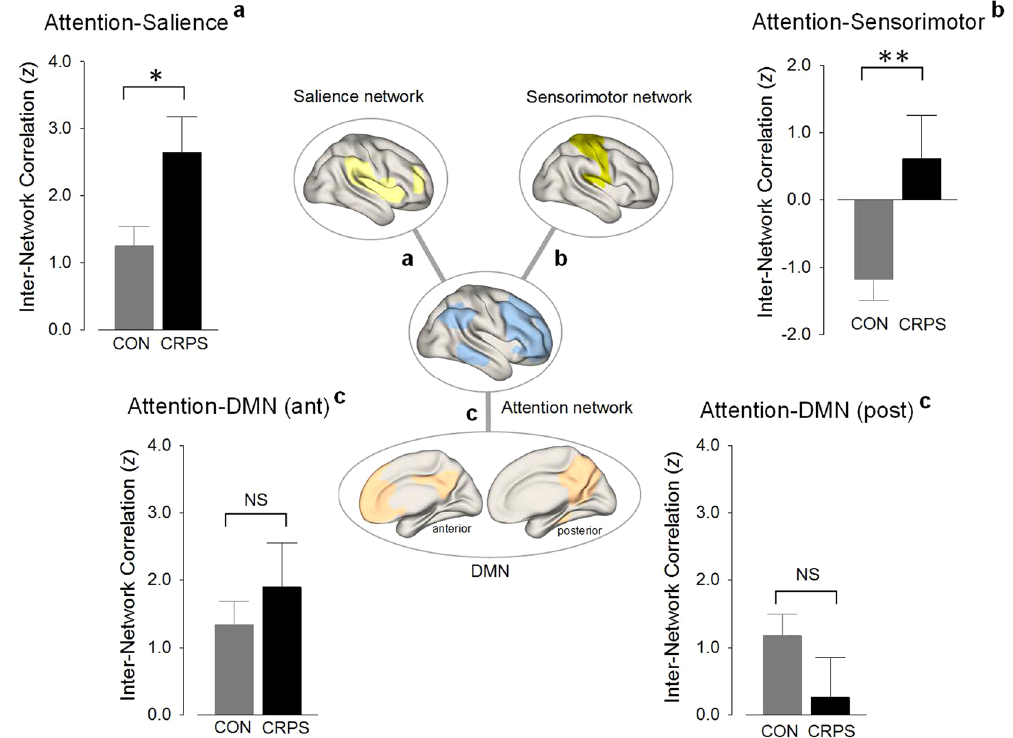
Figure 2. Inter-network correlations between brain networks in the CRPS and control groups. Functional coupling of the attention and salience networks was greater in the CRPS group relative to the control group. Enhanced inter-network connectivity between the attention and sensorimotor networks was also observed in the CRPS group, as compared with the control group. However, there were no significant group differences in the inter-network connectivity between the attention and default mode networks. * Permutation-adjusted P < 0.05; ** Permutation-adjusted P < 0.01; DMN, default mode network; NS, non-significant; CON, control; CRPS, complex regional pain syndrome; ant, anterior; post,